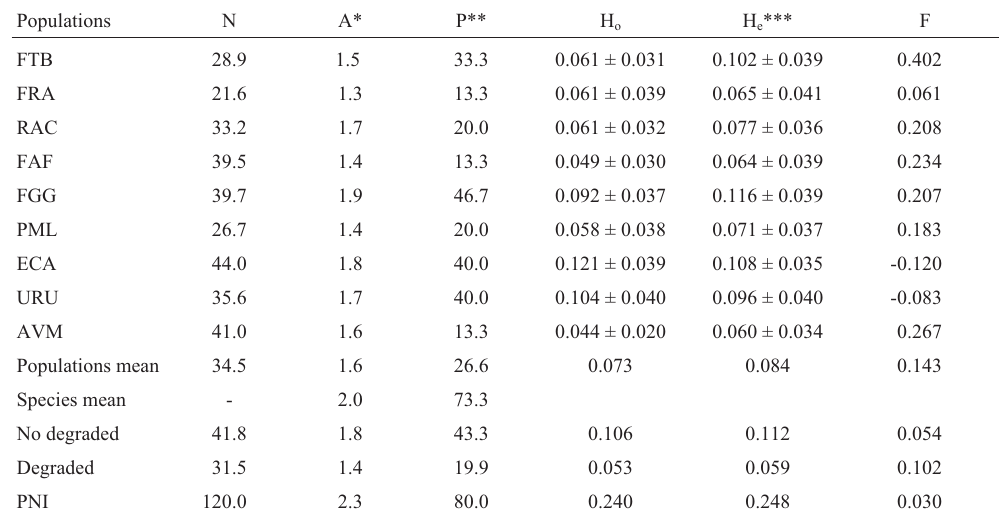
Table III - Genetic diversity indexes for nine Araucaria angustifolia populations based on 15 loci.